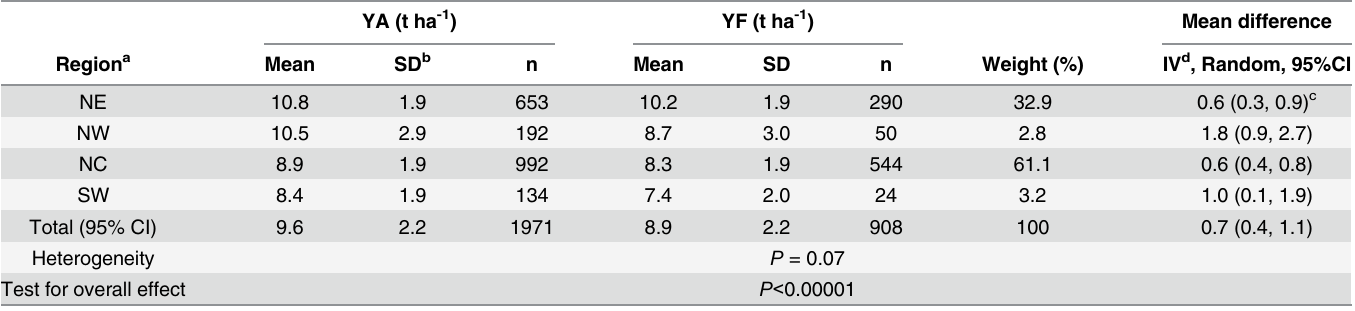
Table 1. Yield gaps between attainable yield (YA) and farmers ’ yield (YF) in experimental plots and 95% confidence interval (CI) in different produc- tion regions of